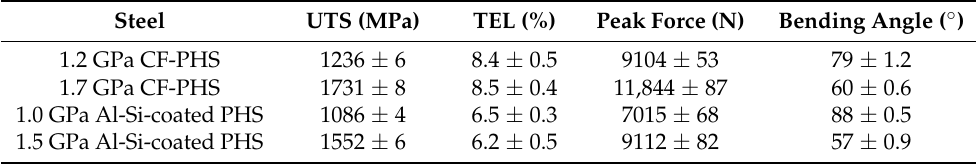
Figure 8. Tensile ( a ) and bending ( b ) performances of the investigated PHSs and reference PHSs. Table 2. Mechanical properties of CF-PHSs and commercial Al-Si PHS . Table 2. Mechanical properties of CF-PHSs and commercial Al-Si PHS.